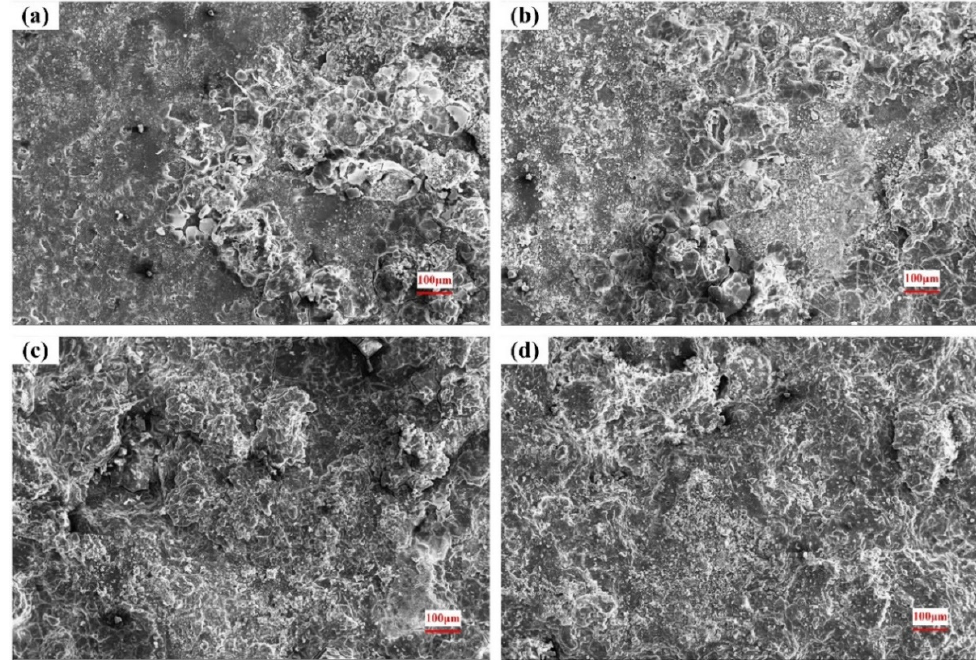
Figure 11. Surface morphology after corrosion in 1.0 mol/L Cl − solution: ( a ) 4 h; ( b ) 8 h; ( c ) 18 h; ( d ) 36 h.